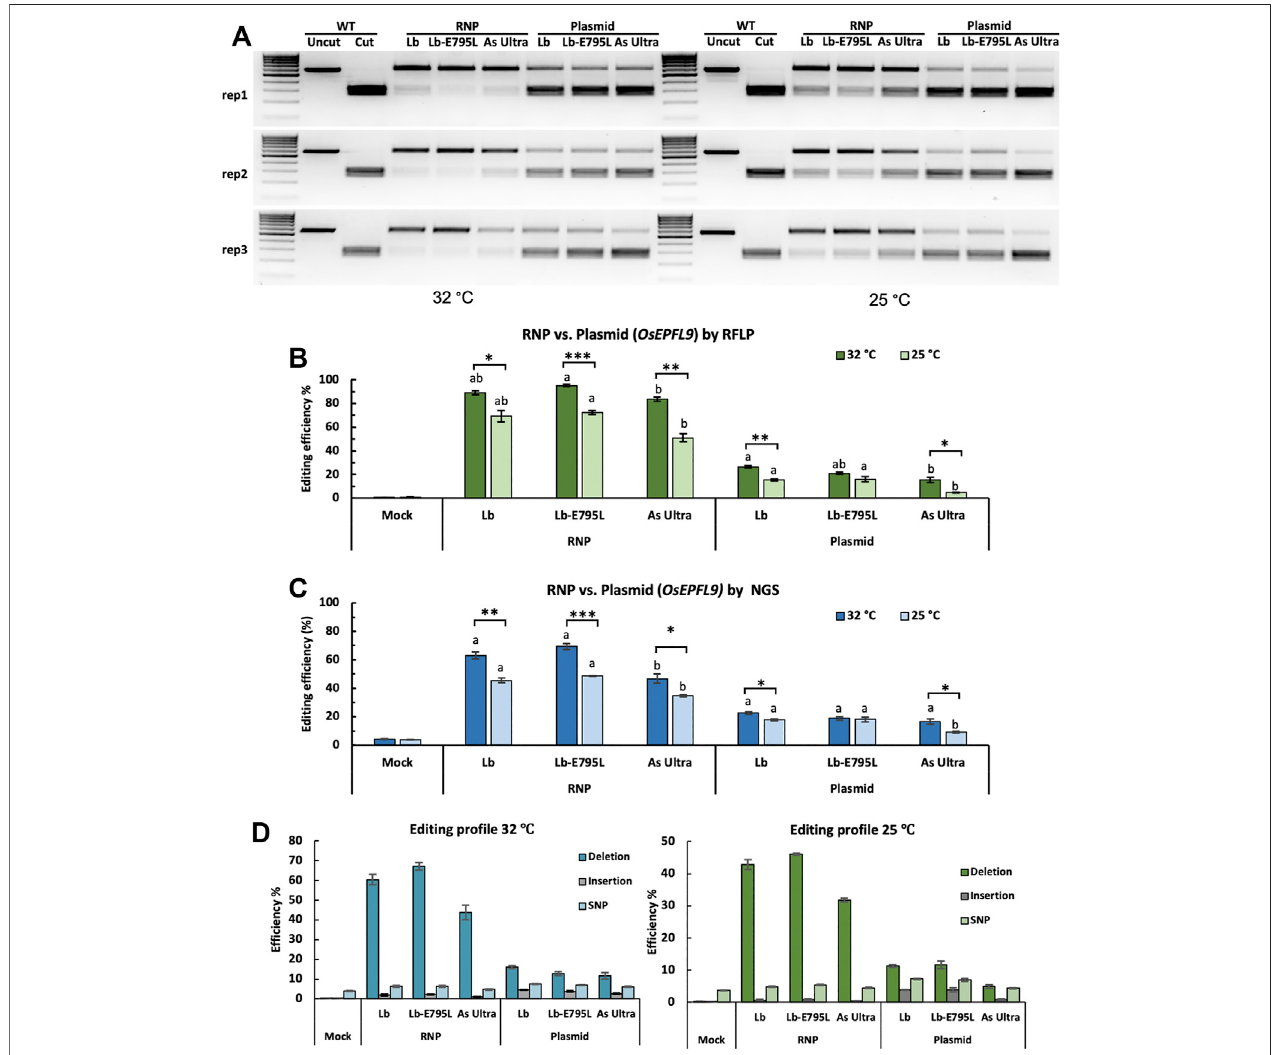
FIGURE 2 | Comparison of Cas12a genome editing using RNP and plasmid delivery. Editing ef fi ciencies of three Cas12a variants in rice cells at the OsEPFL9 site with RNPdelivery and plasmid delivery at 32 ° C and 25 ° C. (A) Editing at the target site is assessed by RFLP as revealed by DNA gel electrophoresis. (B) Quanti fi cation of editingfrequenciesbased onthe RFLP assay. (C) Quanti fi cation ofeditingfrequencies byamplicon deep sequencing. (B,C) Editingef fi cienciesofthree Cas12a variants usingthesamedeliverymethodatthesametemperaturearecomparedusingTukey ’ sHonestSigni fi cantDifference(HSD)test.Treatmentswiththesameletterare not signi fi cantly different when α = 0.05. Editing ef fi ciencies at different temperatures are compared using Student ’ s t-test. Signi fi cant differences were indicated using one asterisk ( p < 0.05), two asterisks ( p < 0.01) or three asterisks ( p < 0.001). (D) Editing pro fi les of three Cas12a variants in rice cells at the OsEPFL9 site with RNP delivery and plasmid delivery at 32 ° C and 25 ° C. Data are presented as mean values ±SEM of three biologically independent replicates.